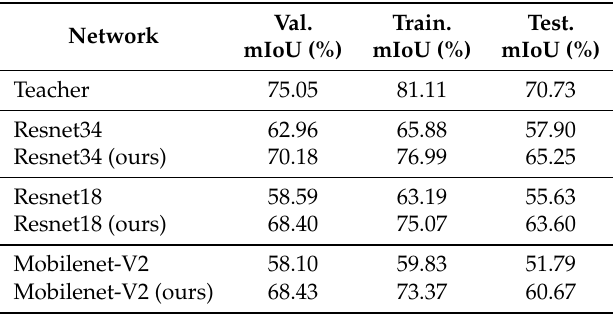
Table 5. Effects of our distillation method on various student networks on the Camvid dataset.